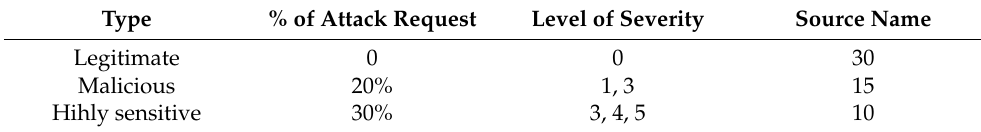
Table 6. Result analysis.